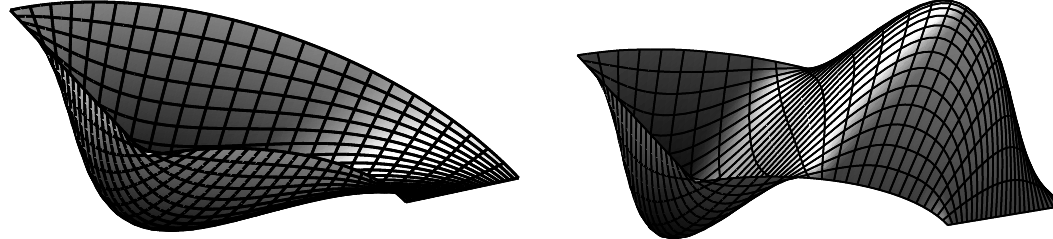
Figure 5: The first (left) and the second (right) vibration mode for the simply-supported quarter section of the elliptical